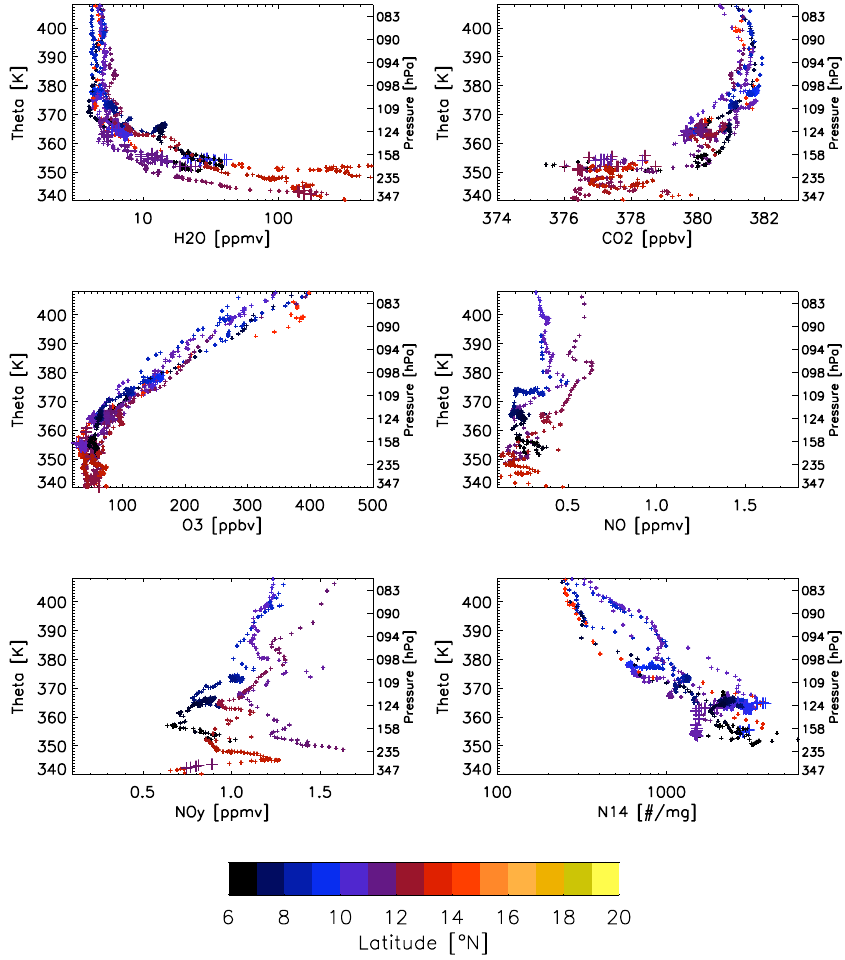
Fig. 10b Vertical profiles of trace gas concentrations (volume mixing ratio in ppbv or ppmv as appropriate) and aerosol mass mixing ratio (particles per mg air), N 14 (14nm to < 1µm), for “non-convective” M55 flights on 4 and 13 August 2006. Profiles are plotted as a function of theta (K) and coloured by latitude where the measurements were made. Crosses indicate points where back trajectories show uplift from below 800hPa during 10 days before the